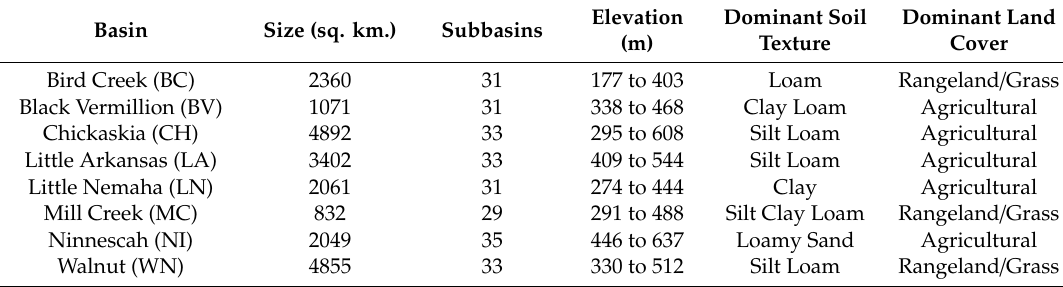
Table 1. Watershed